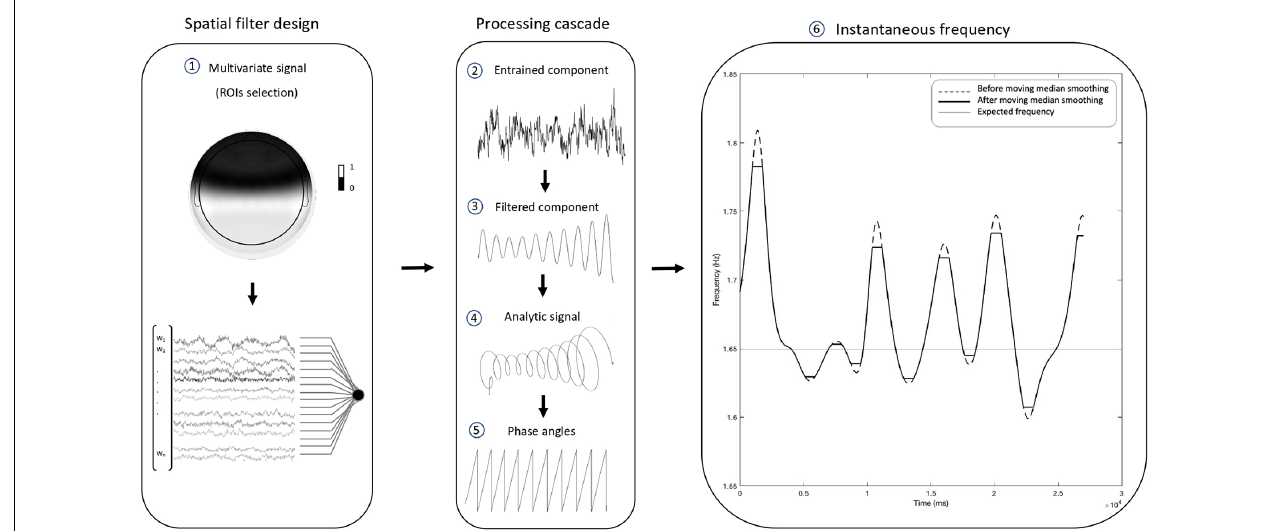
FIGURE 2 | Electroencephalographic (EEG) processing pipeline. The present pipeline illustrates the steps through which the proposed stability index was computed. Following the pre-processing, generalized eigendecomposition (GED) was performed on a broad set of regions of interest (ROIs). The vector of weights w associated with the highest eigenvalue was used as a spatial filter. By multiplying the data from the 37 channels behind the frontocentral line (1), we produced a single time series. The weights of the excluded channels were set to 0. The resulting “entrained component” (2) went through a cascade of computational steps: first, it was narrow-band filtered with a Gaussian filter centered at the stimulus frequency, in order to extract reliable phase time series unaffected by broad-band components (center = 1.65 Hz; width at half-maximum = 0.3 Hz). The “filtered component” (3) was then Hilbert-transformed to produce the “analytic signal” (4), from which we computed the “phase angles” time series (5). Finally, the phase was unwrapped, its first derivative was used to compute the “instantaneous frequency” (6), and a sliding moving median was applied in order to level out eventual artifactual peaks. The plot shows how the pipeline results in a time-varying measure of frequency over time, which fluctuates around the stimulation frequency (i.e., the thin horizontal line intercepting the y-axis at 1.65 Hz). The standard deviation of the instantaneous frequency provides a global measure of the stability of the entrained component for a given time window, which in our case was the whole duration of the task. We named such a global measure “stability index”, for it equals 0 in the case of a flat horizontal line. Such a scenario would be observed in the ideal case of a perfectly stable component oscillating like a simple sine